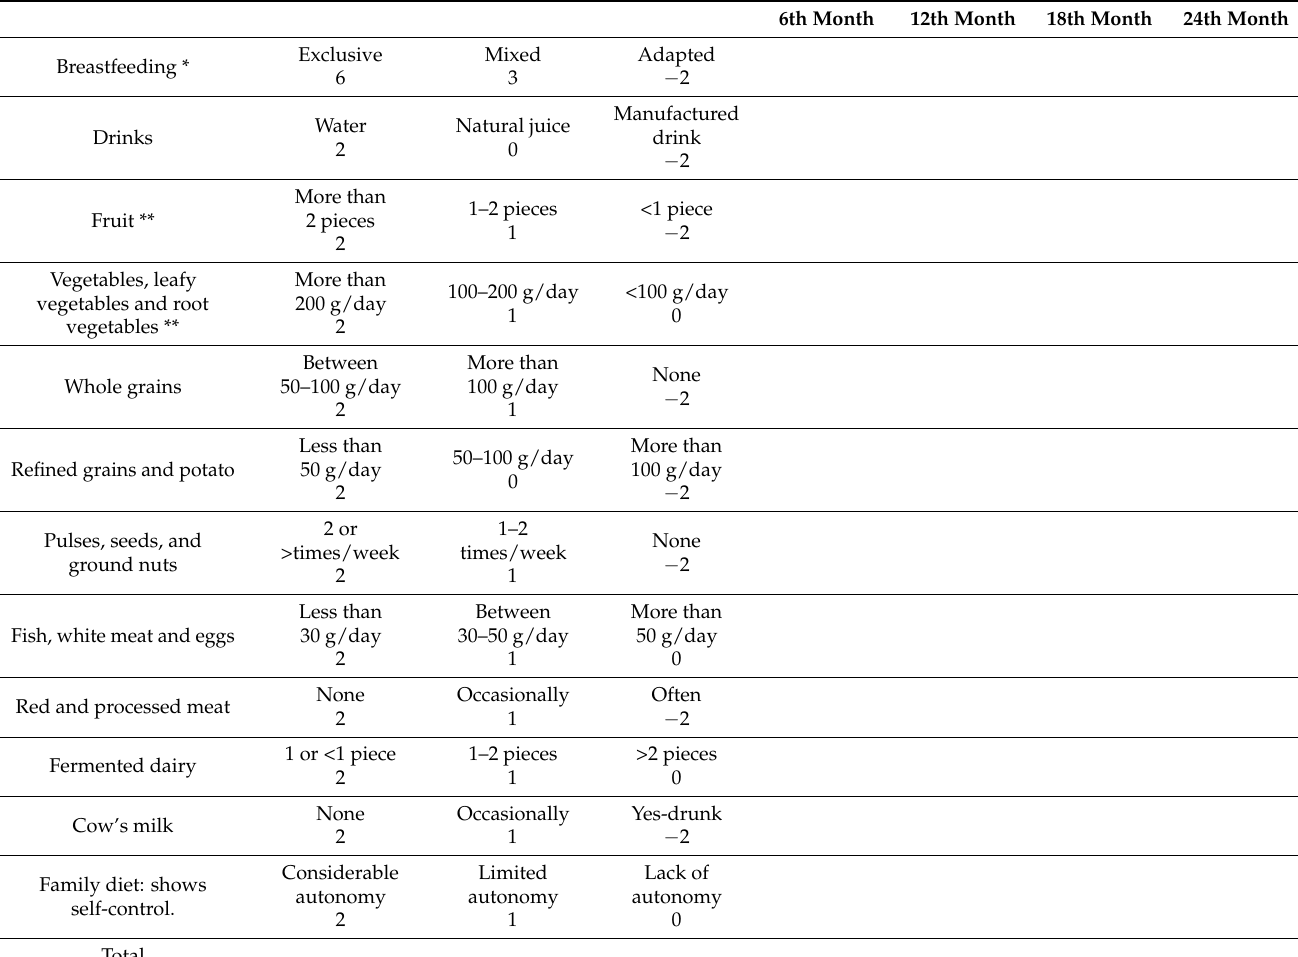
Table A4. Traditional Mediterranean Diet Test in Breastfeeding (TMD-B